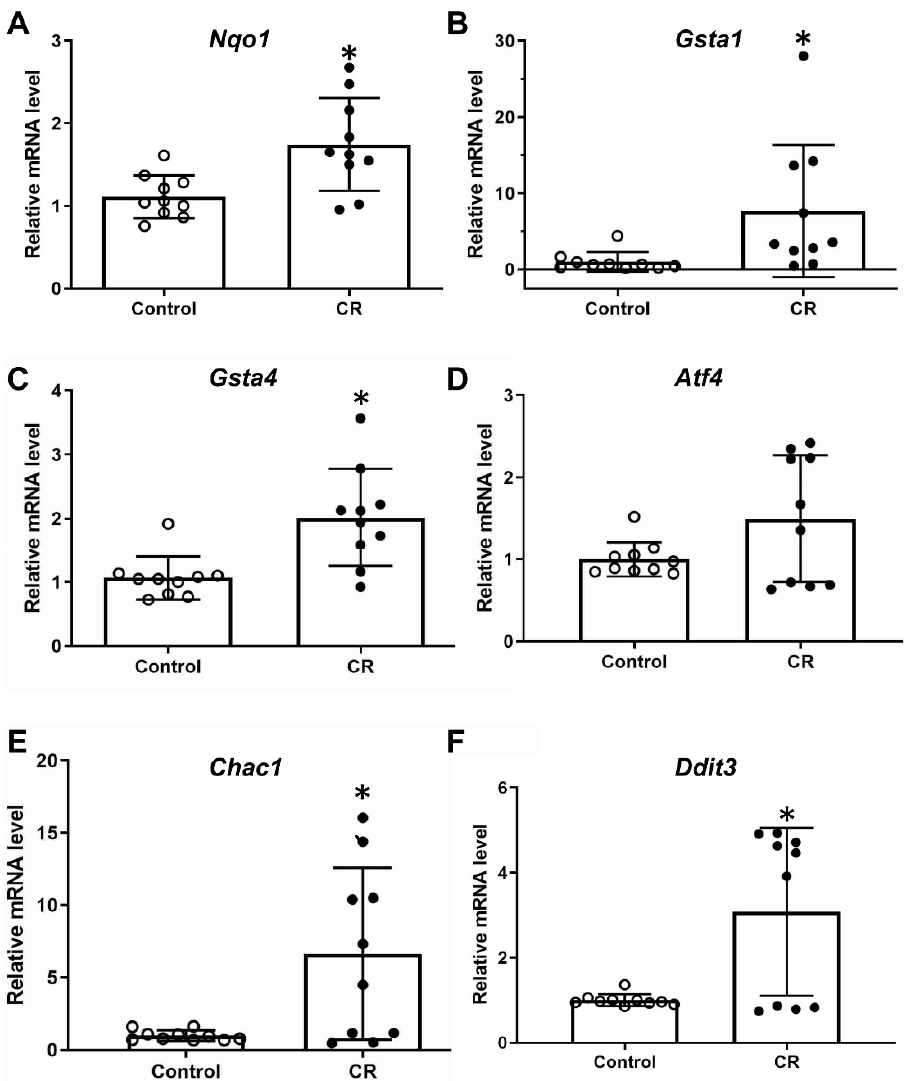
Figure 2. Relative mRNA expression of cytoprotective, antioxidant and stress ‐ response genes in embryonic liver from wild ‐ type mice: Nqo1 ( A ), Gsta1 ( B ), Gsta4 ( C ), Atf4 ( D ), Chac1( E ) and Ddit3 ( F ). n = 10 per group, * p < 0.05. Control: fed ad libitum; CR: calorie restriction.